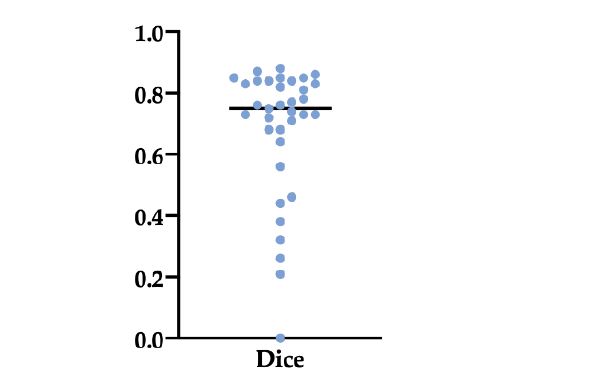
Figure 3. Scatter plot of the Dice coefficients. The line represents the median Dice coefficient of 0.75. The Hausdor ff distance was 8.1 ± 2.9 mm (mean ± SD), respectively, 8.1 mm (median), whereas the Euclidean distance of the geometric centers of gravity was 3.7 ± 2.5 mm (mean ± SD) with a median of 3.0 mm, see Figure 4.